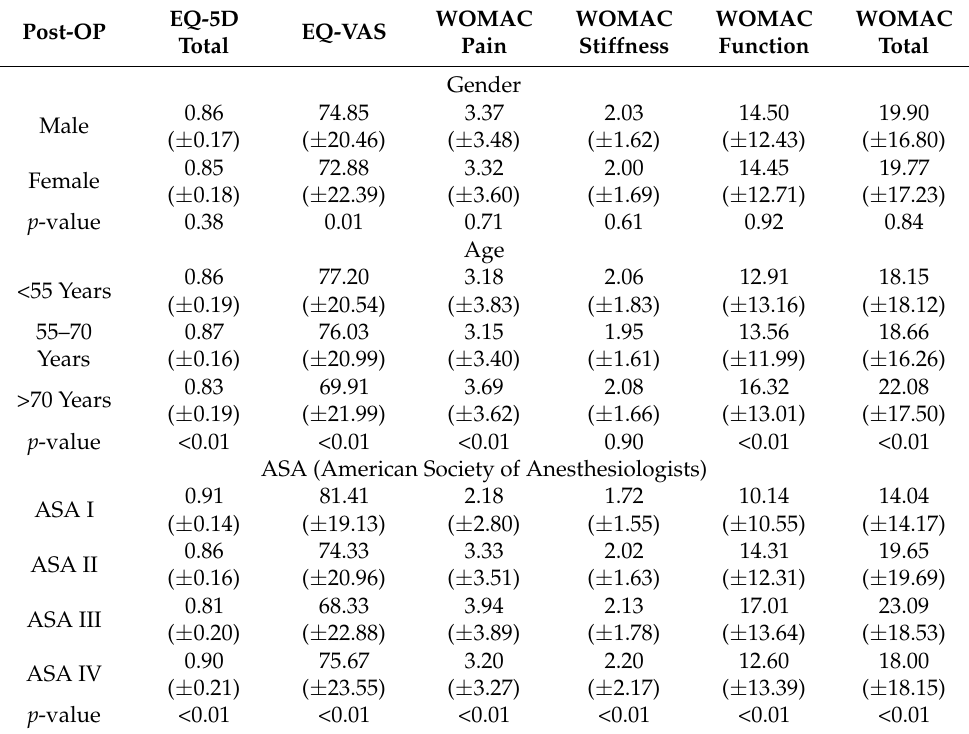
Table 3. EQ-5D Total, EQ-VAS, WOMAC Pain, WOMAC Stiffness, WOMAC Function and WOMAC Total overview of mean values, standard deviations and p -value. Divided by gender, age and